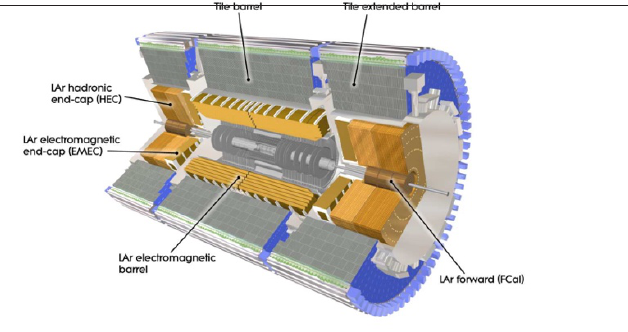
Fig. 1. Layout of ATLAS Calorimeter systems including TileCal (Tile) and Liquid Argon (LAr). Figure is taken from Ref. [2].